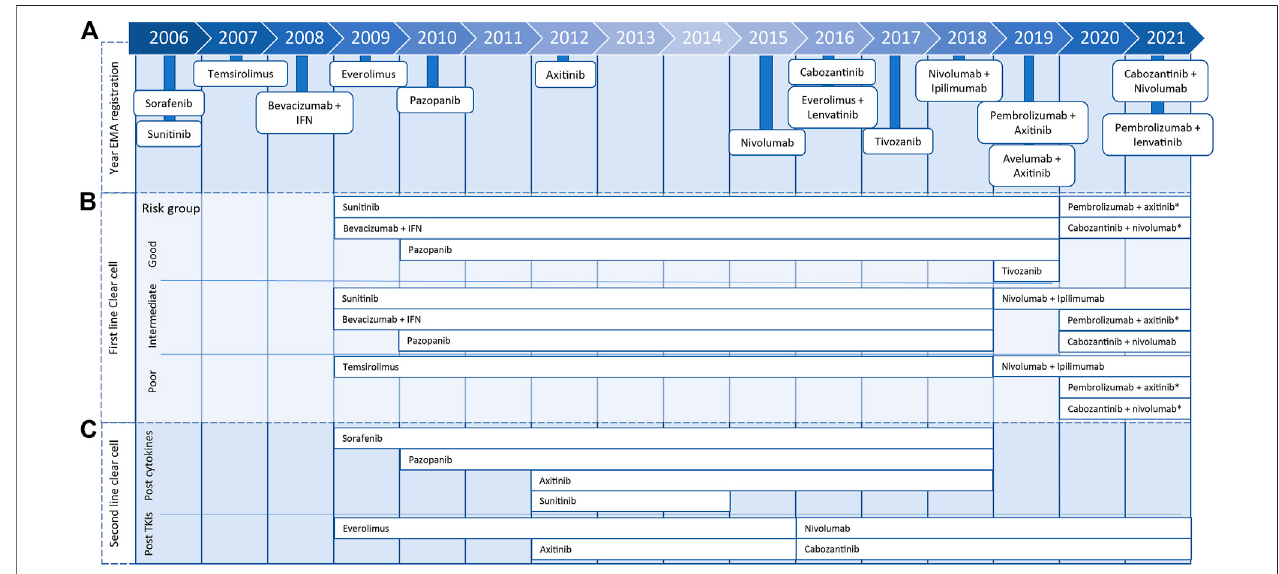
FIGURE 1 | Timeline presenting year of marketing authorization by European Medicines Agency of metastatic renal cell carcinoma treatments (A) and years in which treatment was included for clear cell renal cell carcinoma treatment in ESMO Clinical Practice Guidelines for diagnosis, treatment, and follow-up for fi rst (B) or second line (C) , including 2020 eUpdate (*).